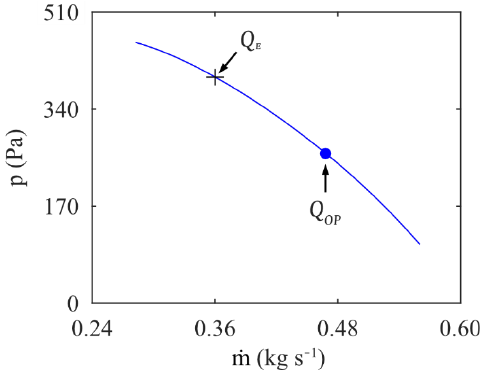
Figure 2. The characteristic curve of the voluteless fan at the rotation speed of 2800 rpm. Q E is the mass flow rate at the maximum efficiency and Q OP is the mass flow rate at the operation point in this study.